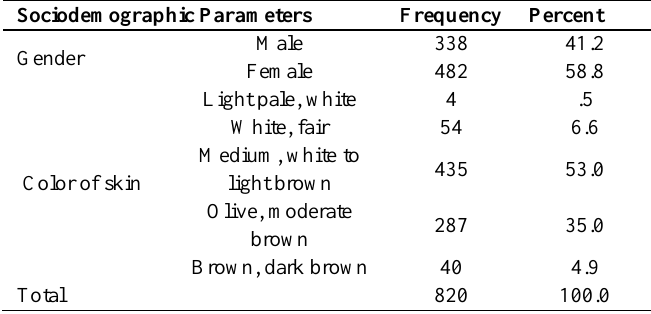
Table 1: Sociodemographic characteristics of the participants Sociodemographic Parameters